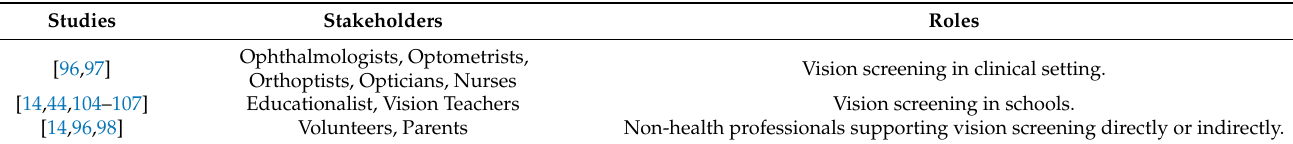
Table 3. Papers grouped based on stakeholders and their roles. Studies Stakeholders Roles Vision screening in clinical